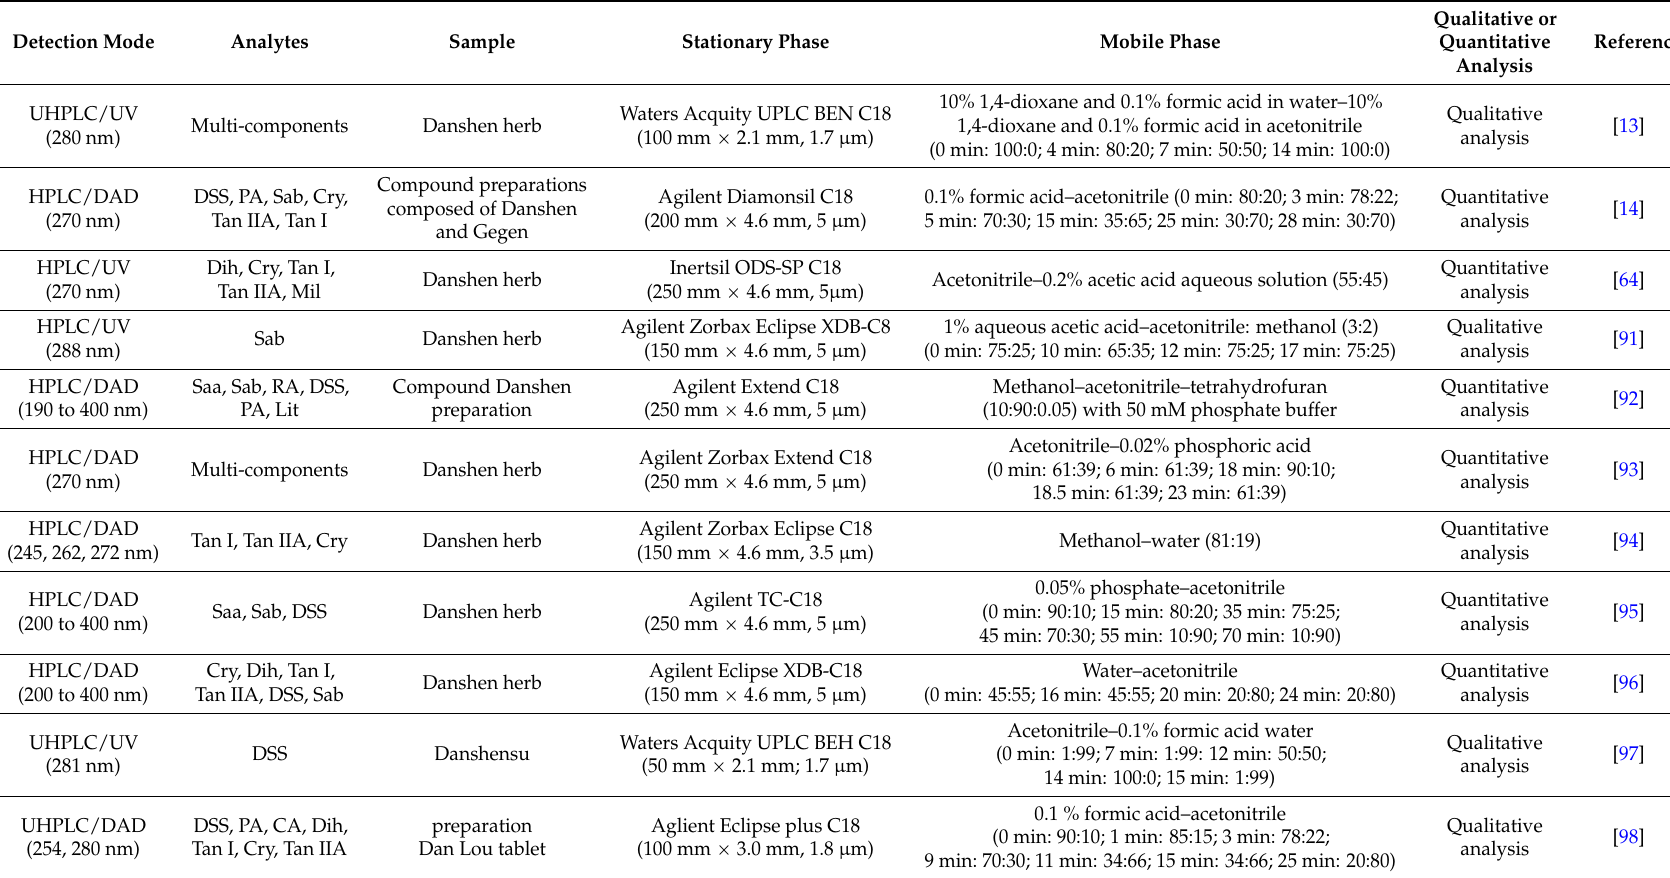
Table 1. LC methods of Danshen and Danshen-containing